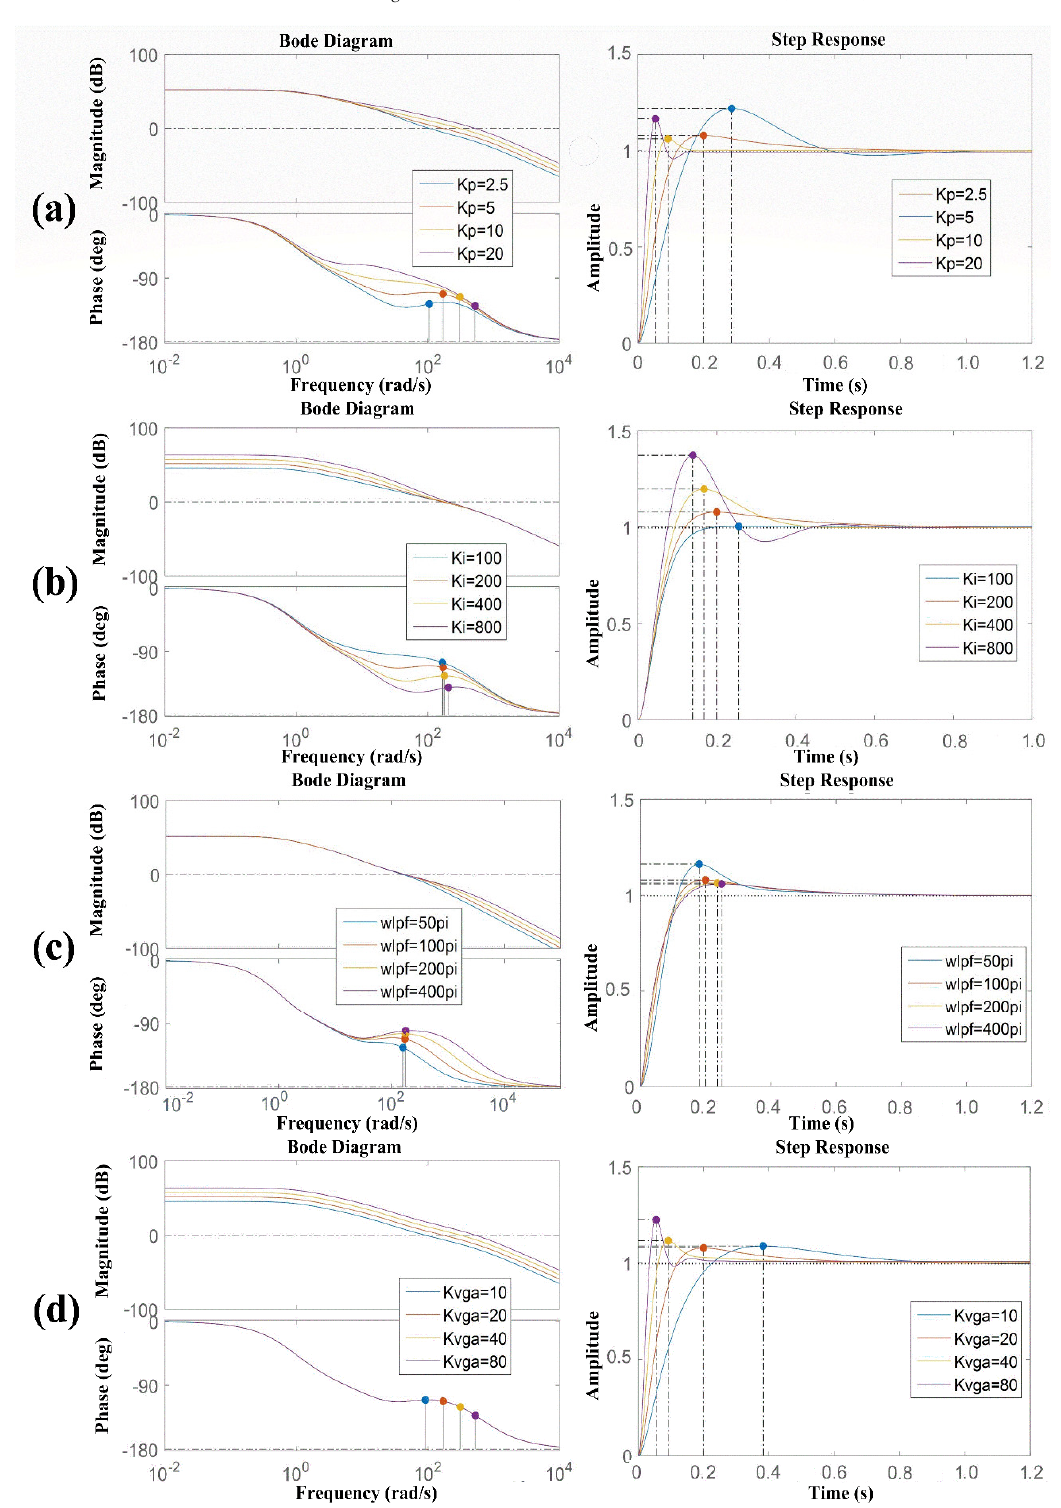
Figure 3. Amplitude frequency characteristics of the driving loop when ( a ) K p , ( b ) K i , ( c ) ω lpf , and ( d ) K vga changed.